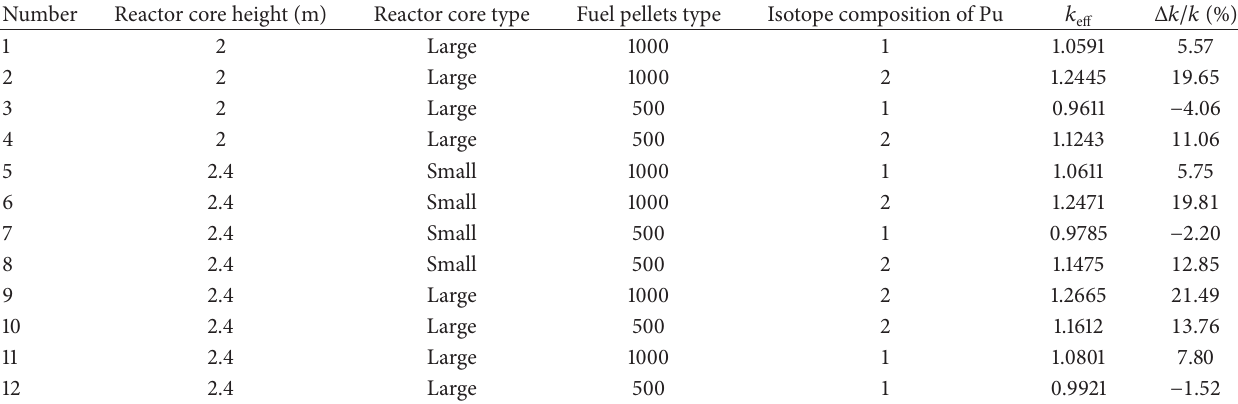
and reactivity margin of the calculated type of eff